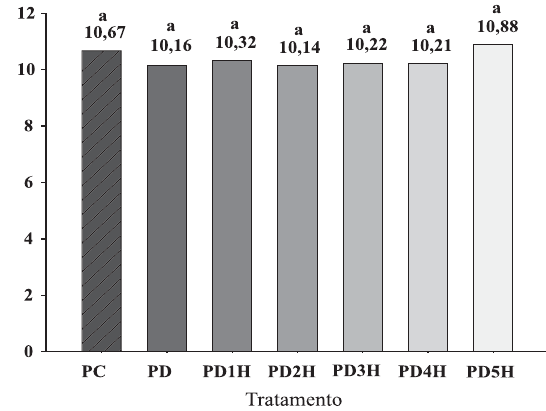
Figura 2. Peso médio dos frutos